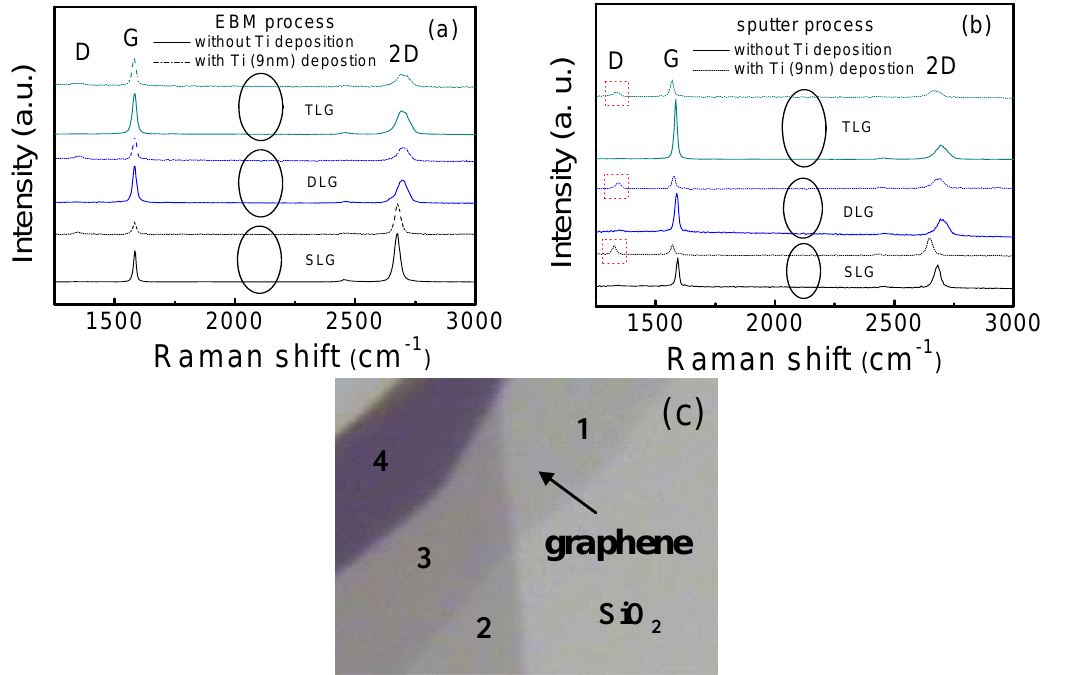
Figure 5. Raman spectra of 1–3 layers graphene with and without Ti (~9 nm) deposition by ( a ) EBM; and ( b ) sputter process, respectively. The noticeable D band in sputtered Ti/grapheme junction, which is related to the defects (carbon vacancies) in graphene, is marked by a red dash box in Figure 5b; ( c ) The optical image of Raman sample. 1, 2, 3, and 4 in Figure 5c represent SLG, DLG, TLG, and MLG (multi-layer graphene),